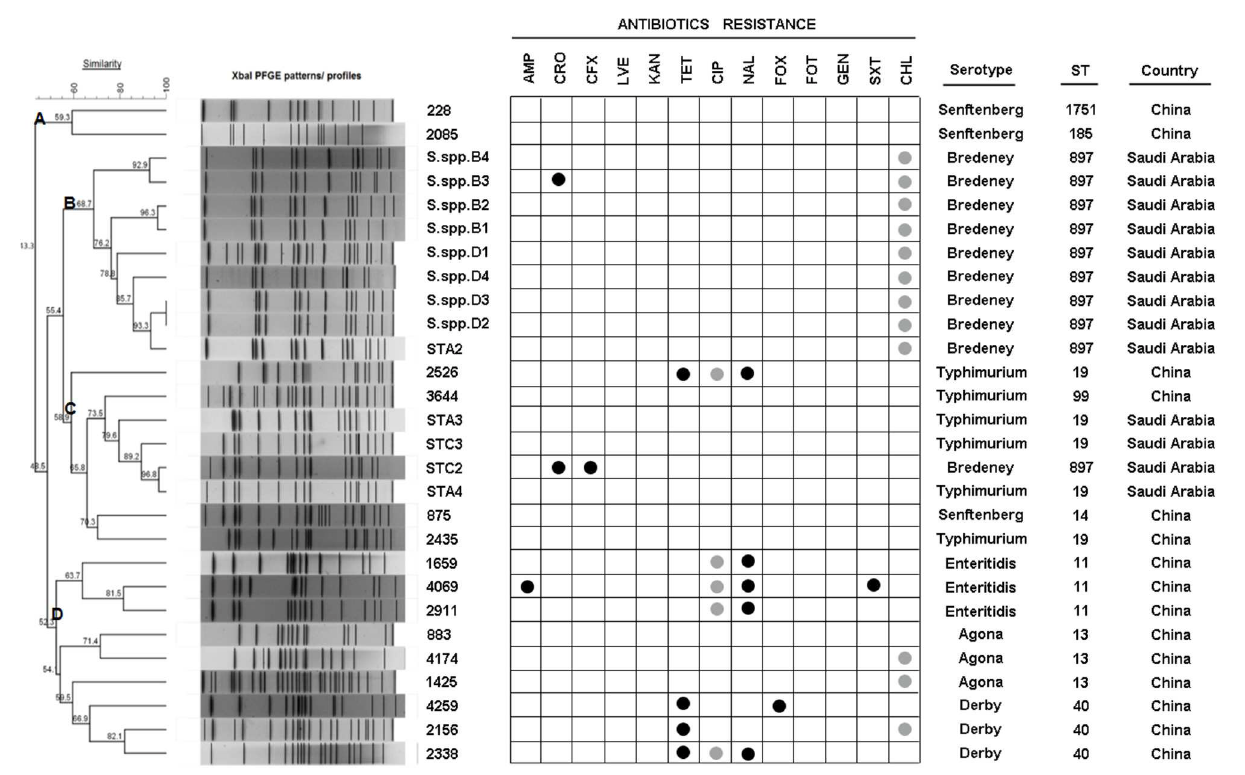
FIGURE 2 | PFGE XbaI patterns, ID, antibiotic-resistance, serotype, sequence type (ST), and origin of 28 isolates. Dendrogram showing the cluster analysis of different PFGE XbaI patterns from 28 isolates generated by Bionumerics software using UPGMA methods. Antibiotic-resistance was detected by MIC and disk diffusion. Serotypes were detected using agglutination tests. STs were determined by